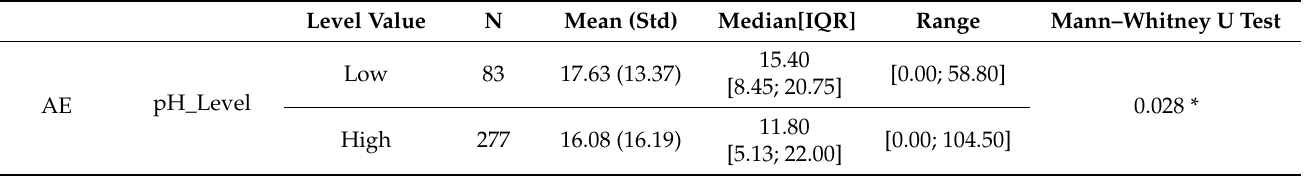
Figure 2. Representation of the mean AE (panel ( A )) and MARD differences (panel ( B )) between both considered studies (HPHF-A and HPHF-W). The grey area represents the 95% CI.